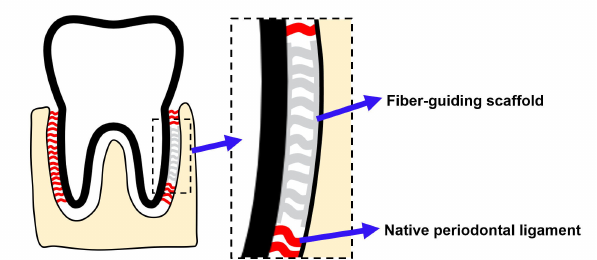
Figure 1. The concept of the fiber-guiding scaffold for PDL reconstruction. A fiber-guiding scaffold is composed of microfibers mimicking native PDL. When the scaffold is placed at the damaged PDL area, the microfibers will guide the growth of cells and formation of fiber bundles.